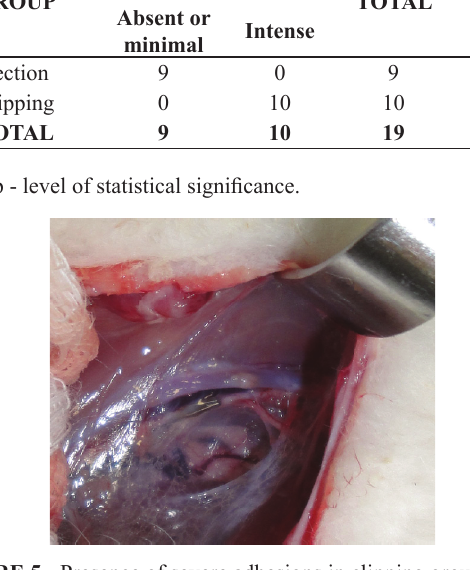
FIGURE 5 - Presence of severe adhesions in clipping